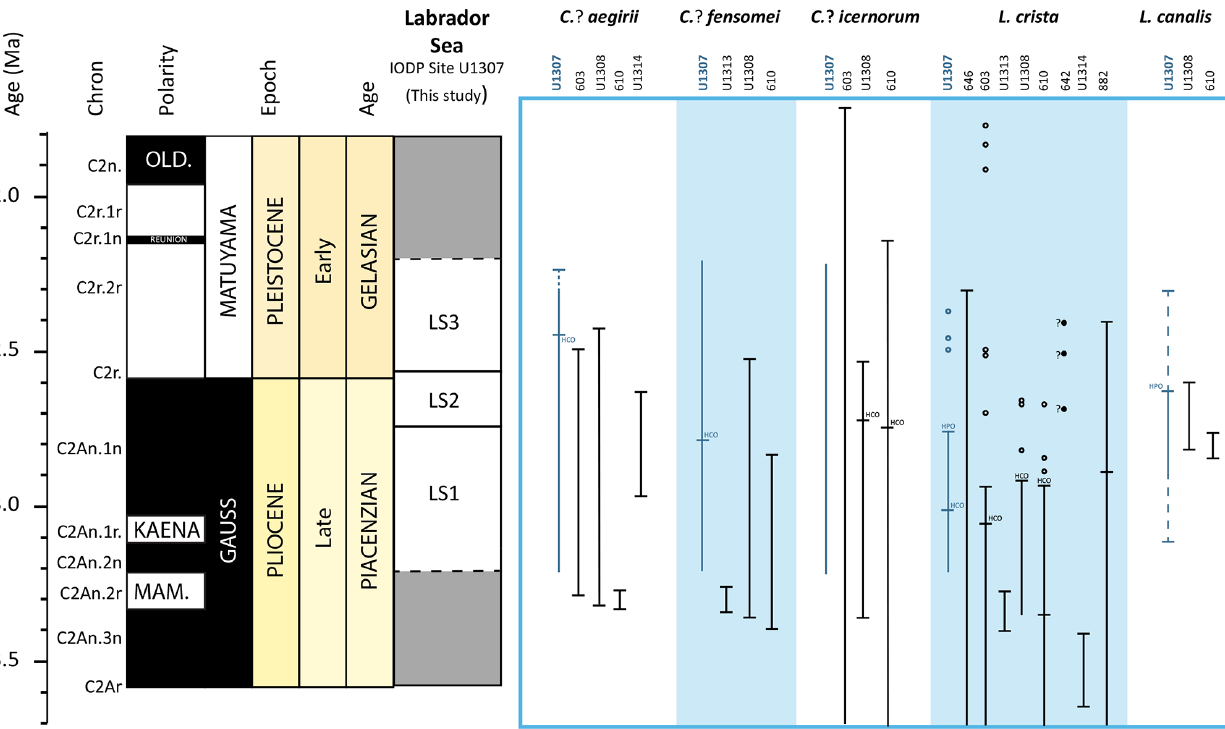
Figure 5. Adapted from De Schepper and Head (2014). Selected acritarch stratigraphic ranges from different sites across the North Atlantic (DSDP Sites 603 and 610; ODP Sites 646, 642 and 907; IODP Sites U1308, U1313 and U1307) and North Pacific (IODP Site U1314, ODP Site 882). Old: Olduvai Subchron; M: Mammoth Subchron; HCO: highest common occurrence; HPO: highest persistent